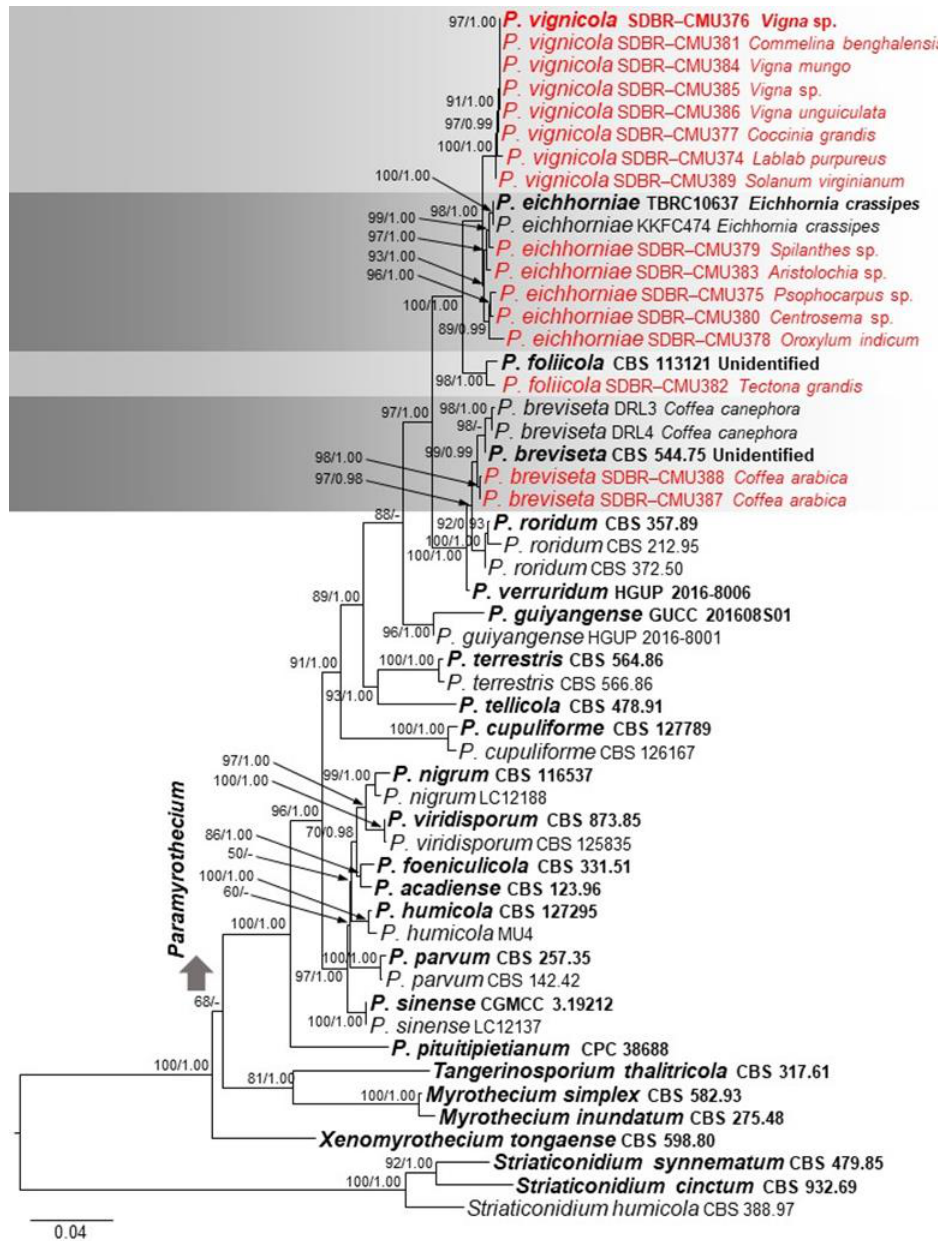
Figure 3. Phylogram generated from maximum likelihood analysis based on combined ITS, cmdA , rpb2 , and tub2 sequenced data. Fifty-three strains are included in the combined sequence analyses, which comprise 1760 characters with gaps. Single gene analyses were also performed, and topology and clade stability were compared from combined gene analyses. Striaticonidium cinctum (CBS 932.69), S. humicola (CBS 388.97), and S. synnematum (CBS 479.85) are used as the outgroup taxa. The best scoring RAxML tree with a final likelihood value of − 8176.4871 is presented. The matrix had 524 distinct alignment patterns. Estimated base frequencies were as follows; A = 0.2266, C = 0.2915, G = 0.2681, T = 0.2138; substitution rates AC = 1.1215, AG = 5.1556, AT = 1.0792, CG = 1.2292, CT = 11.1203, GT = 1.0000; gamma distribution shape parameter α = 0.3855. The bootstrap support (≥50%) of ML and the p osterior probability values (≥0.9) of BI analyses are indicated above or below the respective branches. The fungal isolates from this study are indicated in red. The type species are indicated in bold.